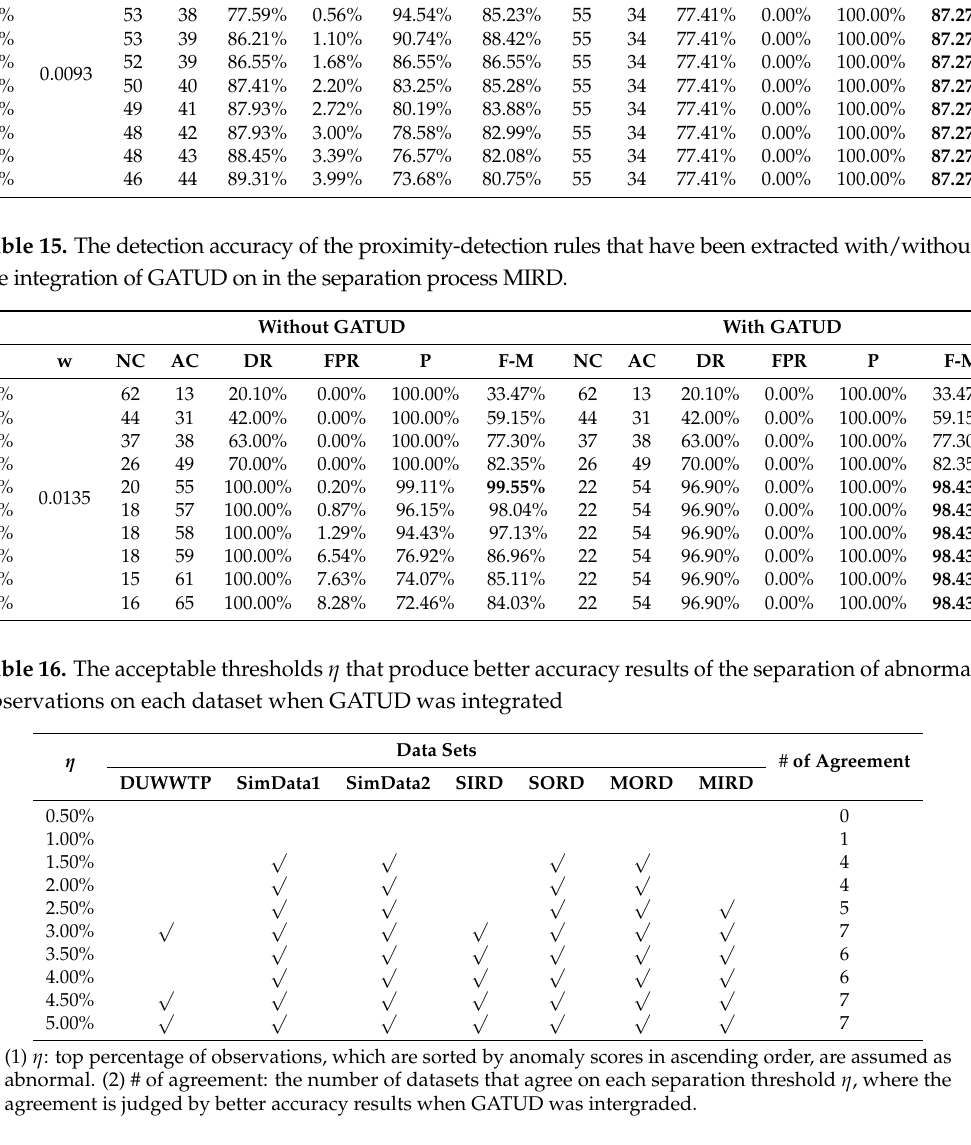
Table 14. The detection accuracy of the proximity-detection rules that have been extracted with/without the integration of GATUD on in the separation process MORD.